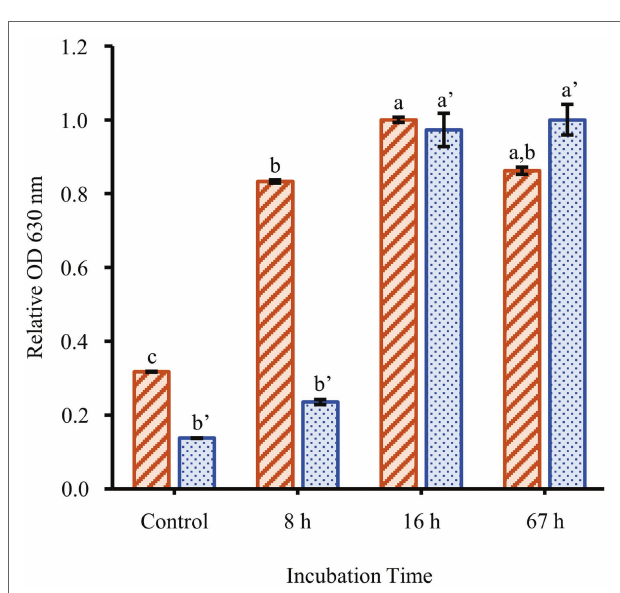
FIGURE 2 | Time course of biofilm formation. The planktonic growth (orange-striped bars) and biofilm formation (blue-dotted bars) of F. johnsoniae wild type grown in a 1/40 dilution of CYE media. Results are reported as relative OD values (averages of at least four replicates; normalized to highest average in dataset). Error bars indicate 95% CI. Different letters above the error bars represent different significance groups among growth and biofilm measurements (one-way ANOVA followed by Tukey test, value of p =